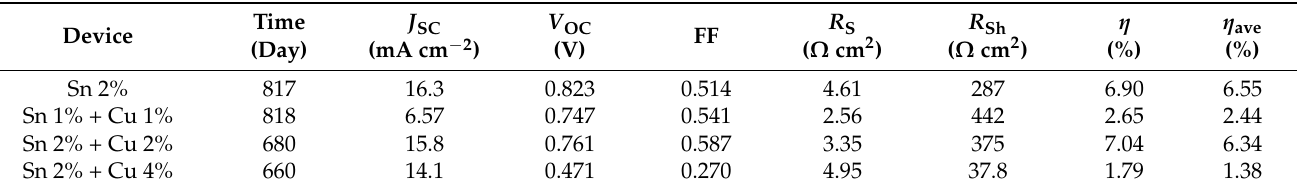
Table 4. Photovoltaic parameters of the present perovskite solar cells after long times.